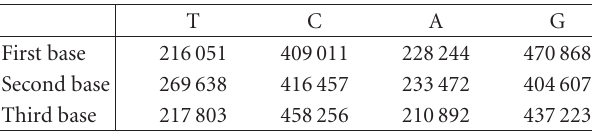
Table 2: Number of nucleotides at the three base sites of a codon in the coding sequence of Mycobacterium tuberculosis .